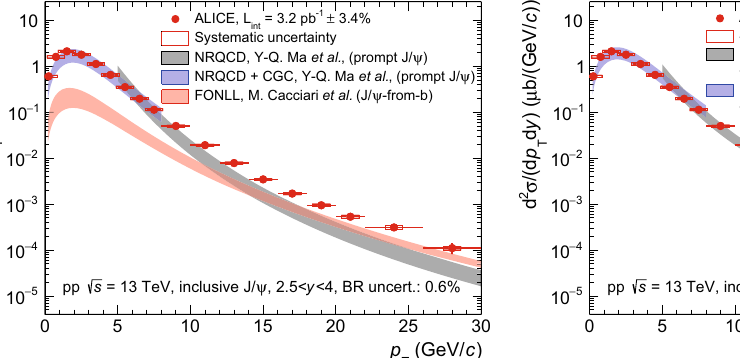
Fig. 7 Left panel J /ψ differential cross sections ( red circles ) in pp √ s = 13 TeV compared to NLO NRQCD ( grey ) [35], collisions at LO NRQCD coupled with CGC ( blue ) [36] and FONLL ( red ) [37].